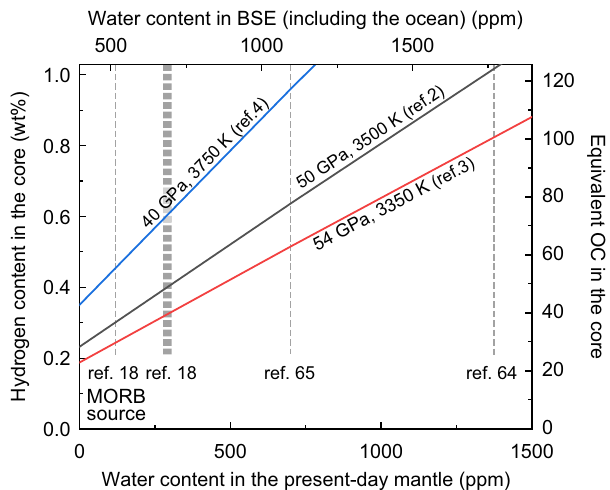
Fig. 3 Estimate of hydrogen concentration in the core based on single- stage core formation models. Three solid lines show our estimates of the hydrogen content in the core as a function of residual H 2 O abundance in silicates ( = present-day BSE water content) at the labeled P – T conditions 2 – 4 . The BSE water content depends largely on the average mantle abundance (lower horizontal axis) 18,64,65 . Even a modest amount of water in the present-day mantle 18 and resulting 687 ppm H 2 O in the BSE suggest 0.32 – 0.61 wt% H in the core. The corresponding ocean mass of water (OC) that includes an equivalent amount of hydrogen is also indicated (right vertical